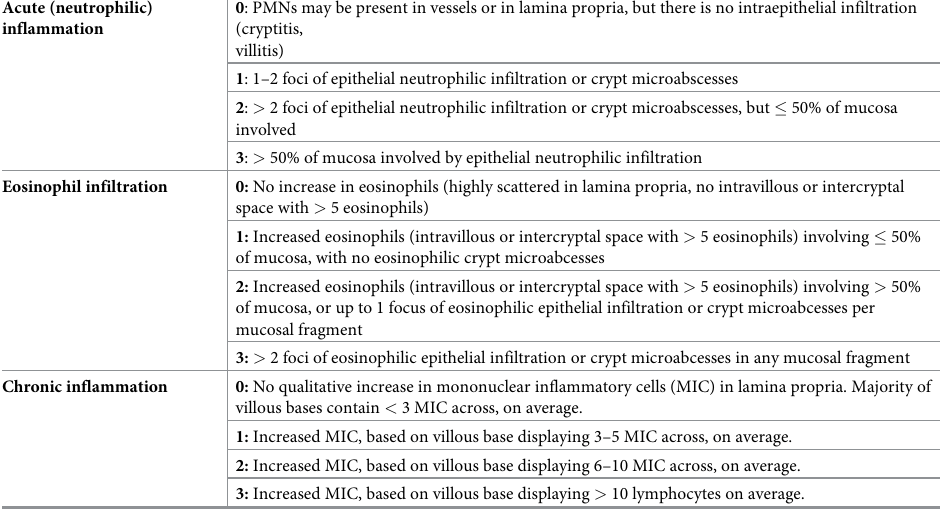
Table 3. Histologic category and scoring